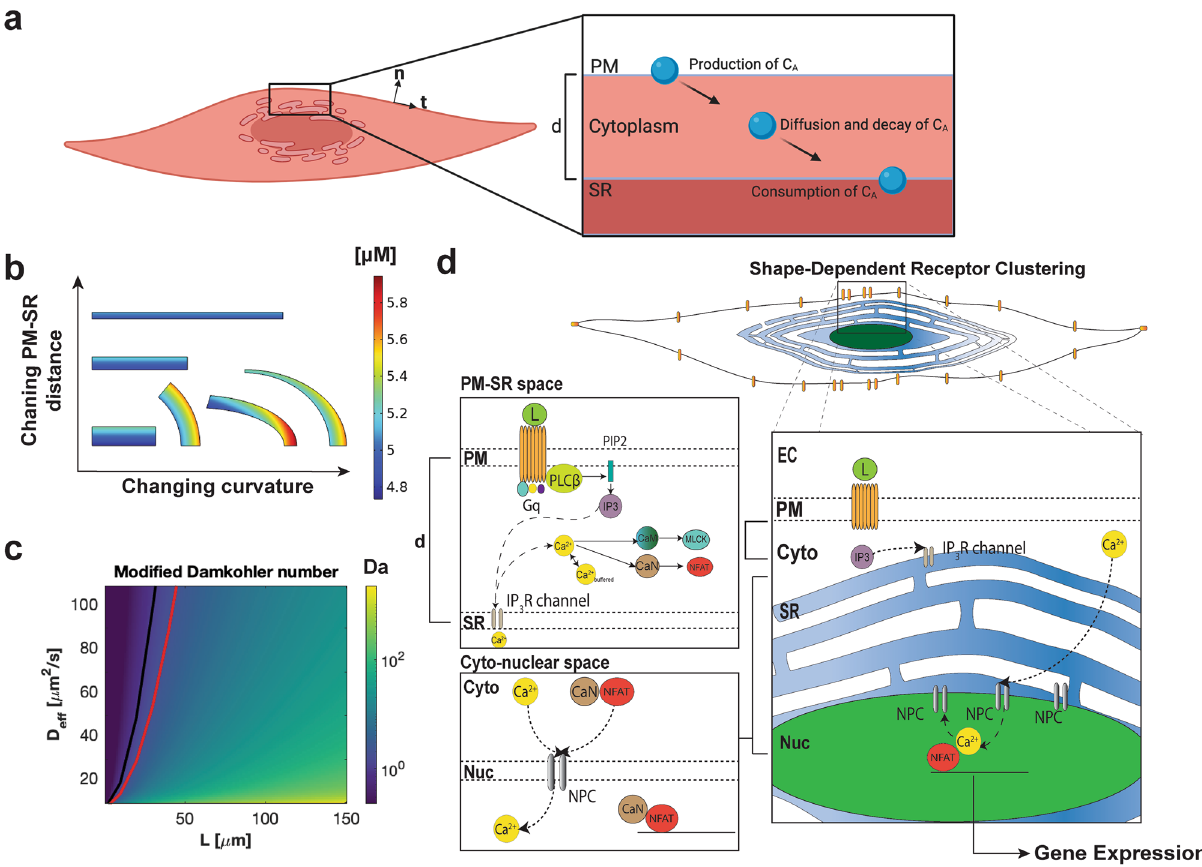
Figure 1. Phenomenological model describing the dynamics of a signaling molecule produced at a membrane and consumed at an organelle membrane compartment as a function of curvature and PM–SR distance. ( a ) Dynamics of a signaling molecule can be described by its production, diffusion, degradation in the cytoplasmic space, and consumption at an intracellular organelle membrane. Both curvature (denoted as t and n) and PM– SR distance differences (denoted as d) can play important roles in signaling dynamics. The interplay between sources, sinks, and boundary fluxes determines signaling dynamics. Schematic created with Biorender.com. ( b ) Six different geometries with the same area were used to test how curvature of the membrane and distance between the plasma membrane (PM) and the inner membrane, a sarcoplasmic reticulum (SR) in this case, affect the spatio-temporal dynamics of the signaling molecule ‘C A ’. Reaction–diffusion modeling in COMSOL predicts that curvature and distance between the PM and SR will both affect the spatial distribution of C A . Here we